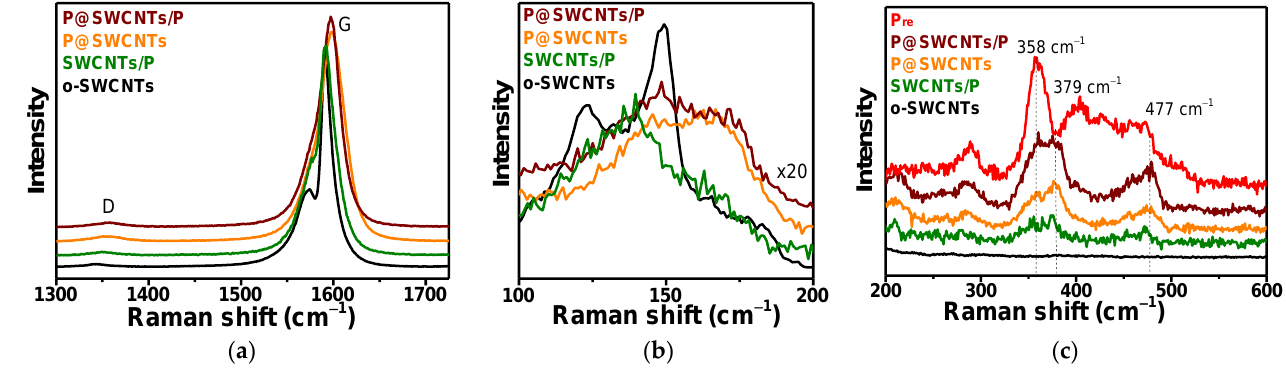
Figure 5. Raman spectra of o-SWCNTs sample and composite nanomaterials: ( a ) the first order region and ( b ) the RBM-mode region, presented with a zoom of 20; ( c ) Raman scattering from 200 to 600 cm – 1 for reference o-SWCNTs and recrystallized phosphorus (P re ) samples and composite nano- materials.